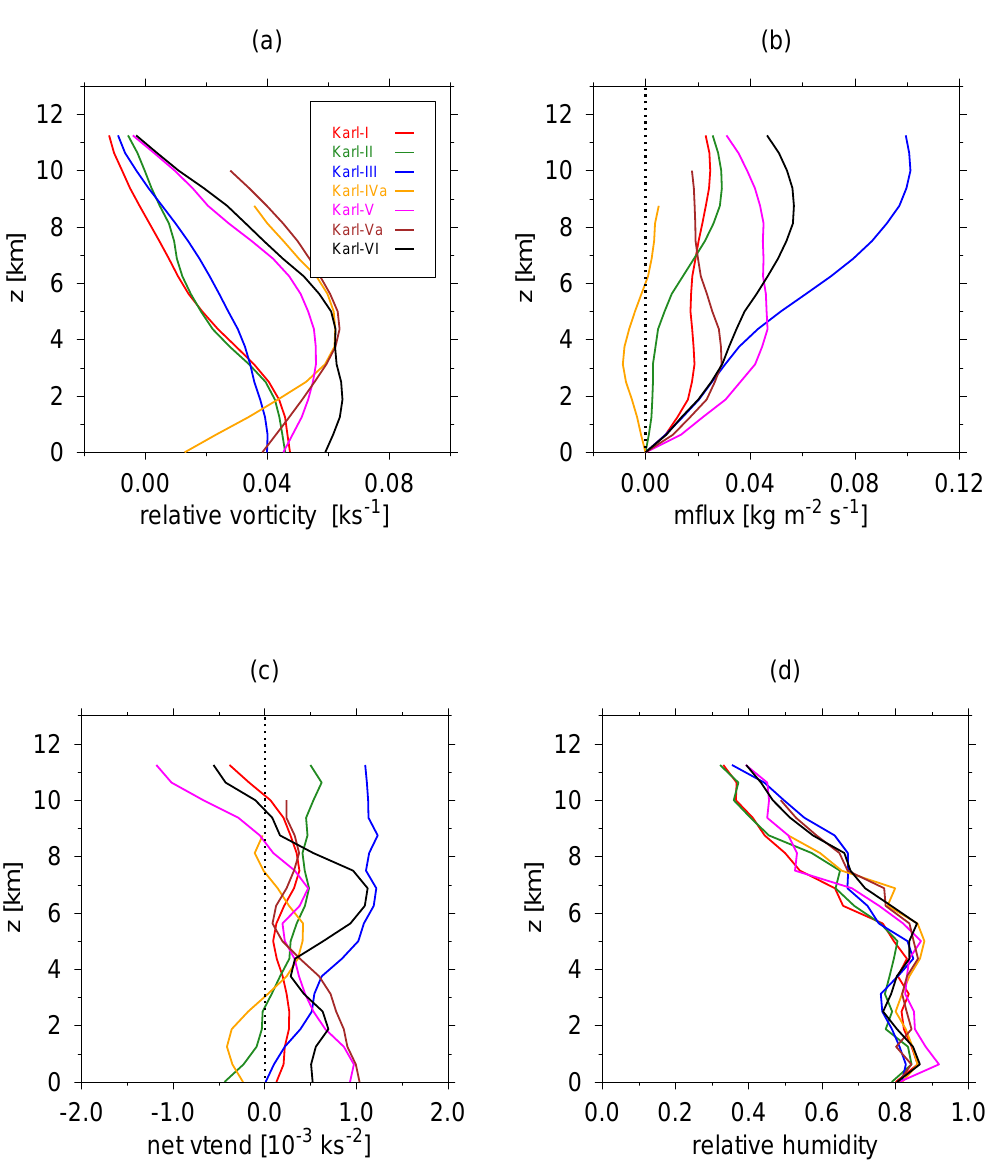
Fig. 2. Horizontally averaged (a) relative vertical vorticity, (b) vertical mass flux, (c) vorticity tendency, and (d) relative humidity for all the Karl missions.